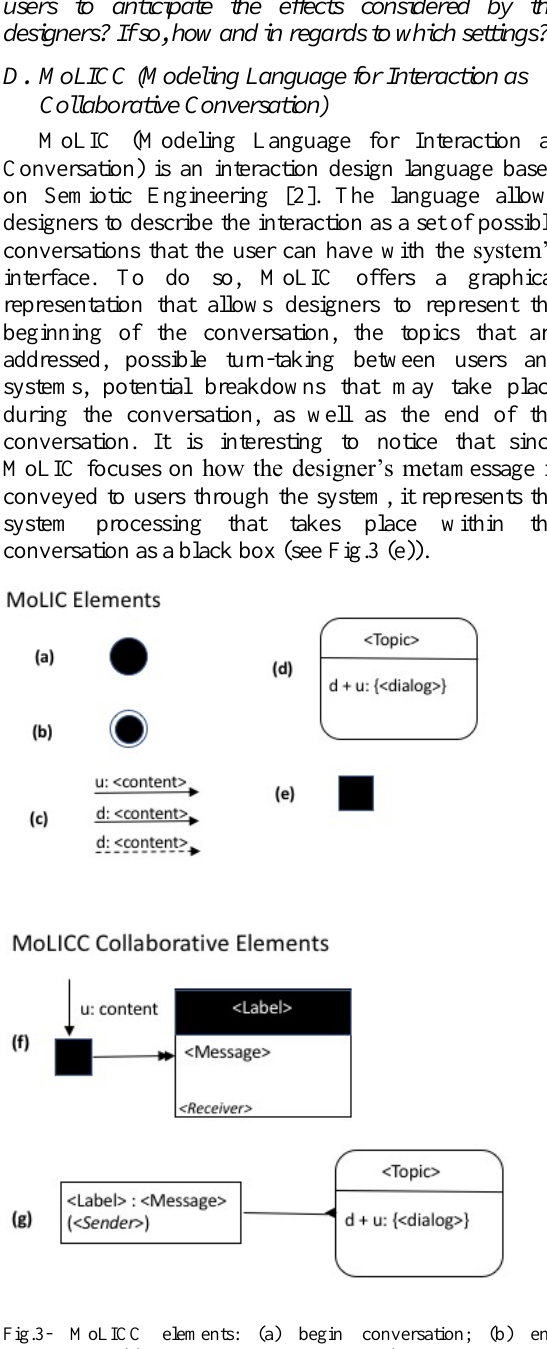
Fig.3- MoLICC elements: (a) begin conversation; (b) end conversation; (c) user and system transitions (marked as u and d , respectively); dashed arrow refers to communicative breakdown; (d) topic of conversation and dialogs; (e) system processing; (f) OMI: Outgoing Message Indicator; (g) IMI: Incoming Message